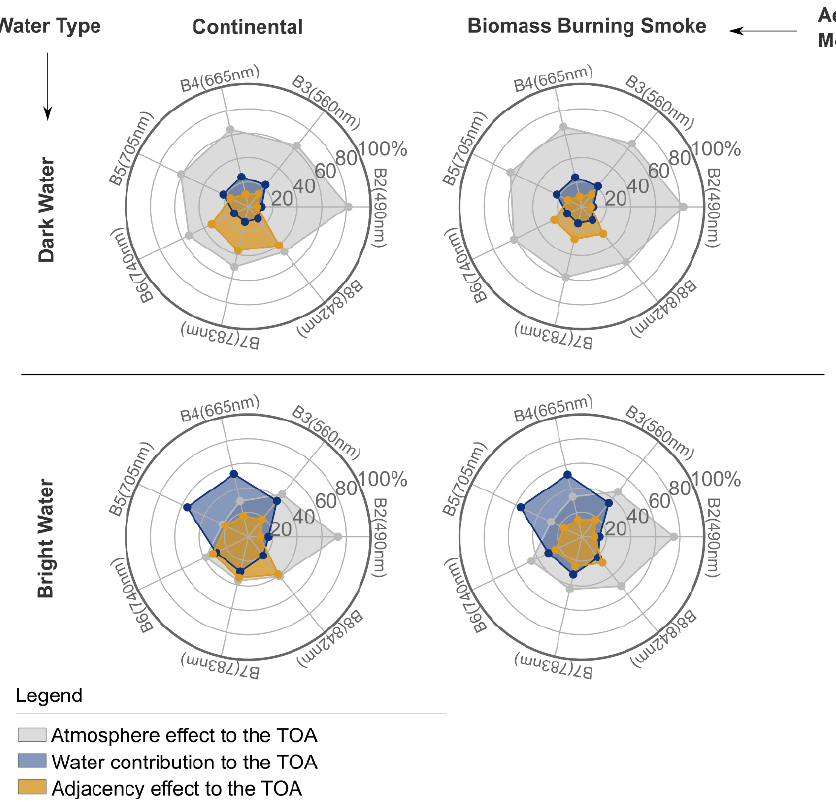
⁄ in %) along visible and ρ adj TOA